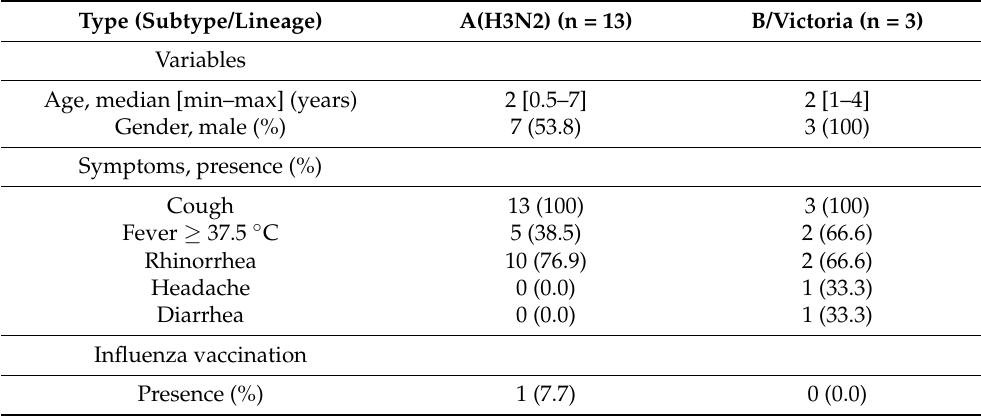
Table 1. Baseline and clinical characteristics of A(H3N2)- and B/Victoria-infected patients confirmed by cycling probe RT-PCR, Myanmar,